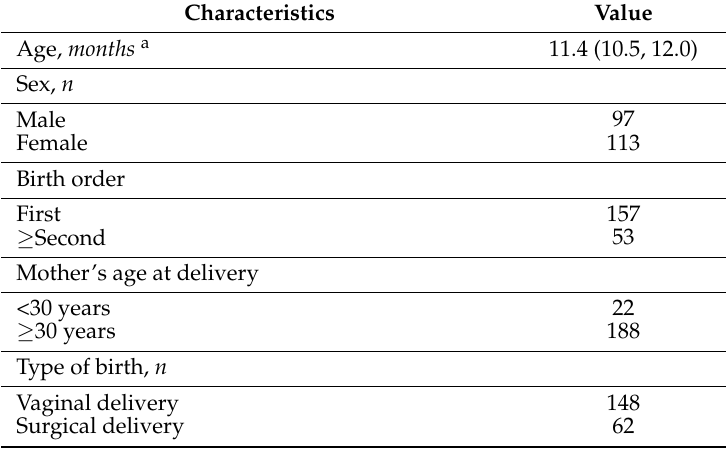
Table 1. Demographic, anthropometric, and diet-related parameters and iron status of 210